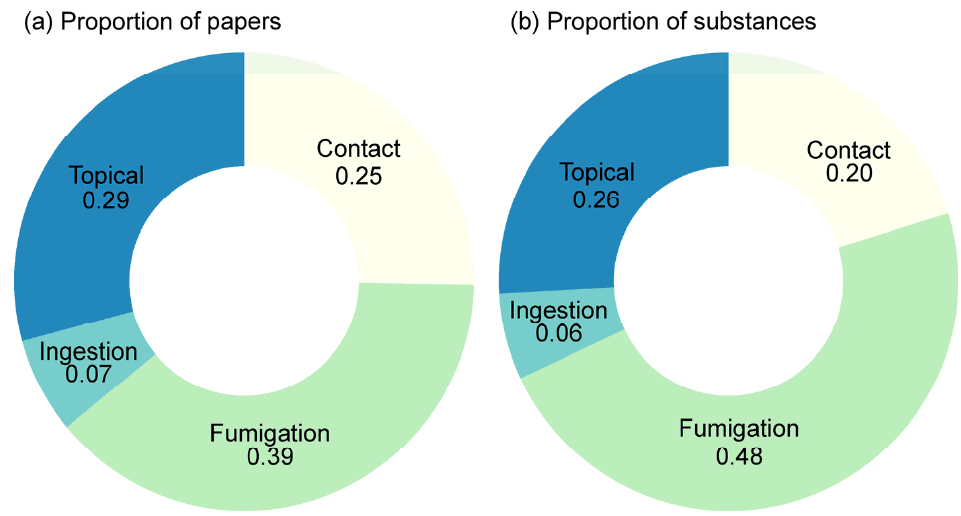
Figure 6. Types of exposure route present in the experiments of the analyzed articles. (Number of papers = 138; however, there are repeated measures, since a paper may contain more than one exposure route or substances. Therefore, n = 178 and n = 1121 for ( a ) and ( b ), respectively). The overall effect of the dataset exhibited low heterogeneity between chemical groups (I 2 = 9%). However, a median heterogeneity between 19% and 49% was observed in the subgroup of terpenes, carbonyl, and phenolics, since the studies evaluating this ef- fect were carried out mainly among butterflies/moths and booklice (Lepidoptera and Psocoptera,